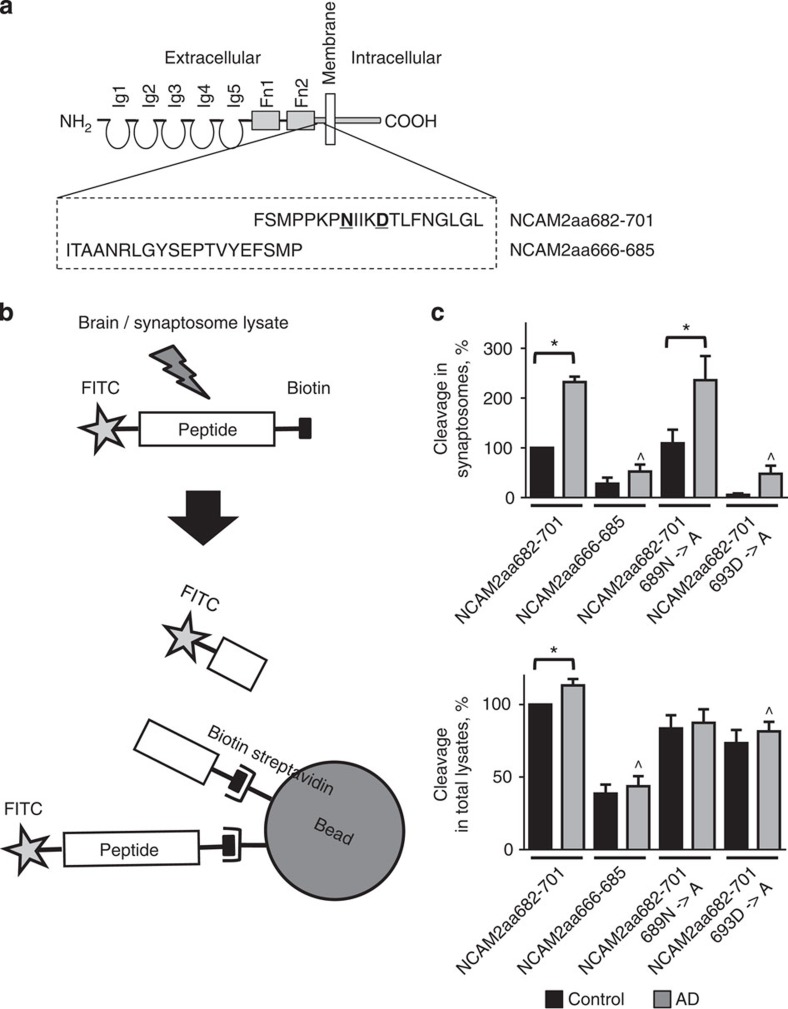
Cleavage of the membrane-adjacent extracellular fragment of NCAM2 is increased in AD brains.(a) Diagram showing the structure of NCAM2. Ig, immunoglobulin-like domain; Fn, fibronectin type III domain. Peptides used in the cleavage assay and corresponding to aa682-701 (NCAM2aa682-701) and aa666-685 (NCAM2aa666-685) of human NCAM2 are shown below. Asparagine 689 and aspartic acid 693 exchanged to alanine in the cleavage assay shown in c are highlighted in bold. (b) Scheme of the peptide cleavage assay. Peptides labelled with FITC and biotin at the N- and C-terminus, respectively, were incubated either with the total brain lysate or lysate of synaptosomes. Non-cleaved peptides and biotin-containing fragments of the cleaved peptides were removed using streptavidin-coated beads. The remaining FITC fluorescence was used as an estimate of peptide cleavage. (c) Graphs show the efficiency of the peptide cleavage (mean+s.e.m.) with the fluorescence signals for NCAM2aa682-701 in controls set to 100%. Lysates from eight controls and eight AD patients were analysed. Note that the efficiency of NCAM2aa682-701 cleavage is higher in AD cases and particularly in synaptosomes. NCAM2aa682-701 cleavage is reduced by mutating aspartic acid 693. *P<0.05 (compared as indicated), ^P<0.05 (compared with NCAM2aa682-701 cleavage in AD) analysis of variance with Tukey's multiple comparisons test.